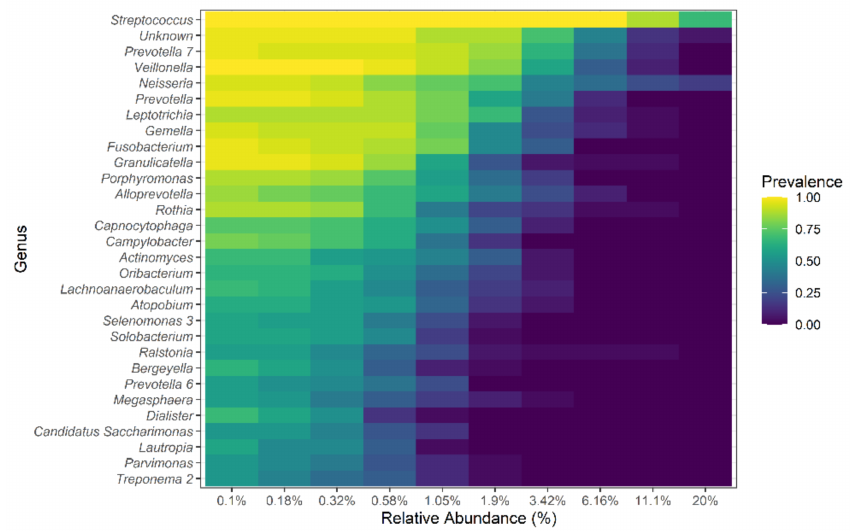
Figure 6. Core lung microbiome at the genus level. The prevalence and relative abundance of the core microbiome at the genus level of both TB patients and HVs. The top 30 genera are